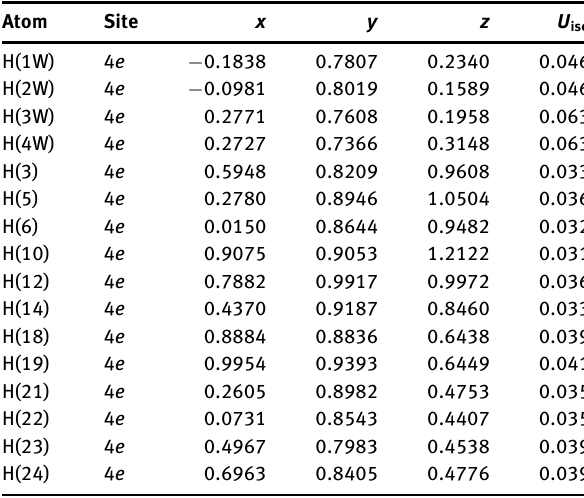
Table 2: Fractional atomic coordinates and isotropic or equivalent isotropic displacement parameters (Å 2